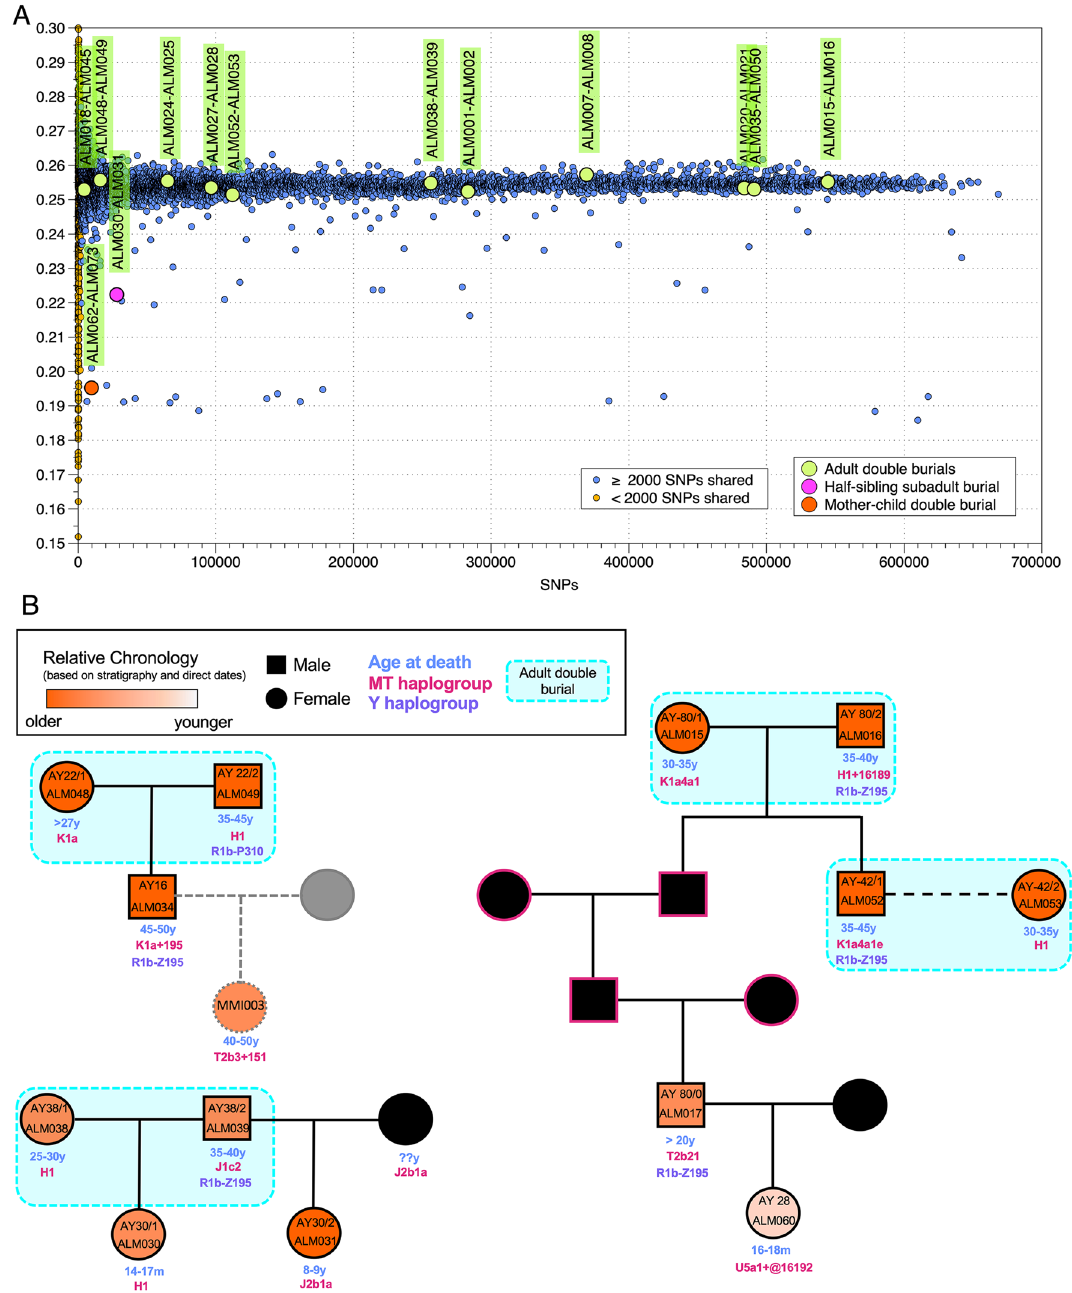
Figure 3. Summary of the genetic results from the double burials at Almoloya. ( A ) Results of the Pairwise- mismatch rate (PMR) analysis including all pairs of individuals from the Iberian Bronze Age available to date. The x-axis shows the number of overlapping SNPs between each pair and the y-axis the coefficient of relatedness. All adult double burials fall within the range of randomly drawn pairs of individuals from the Iberian Bronze Age. ( B ) Reconstructed pedigrees of three cases involving adult double burials and their common offspring. Below the colored squares and circles is the contextual information of all adult double tombs, including sex, age at death, mitochondrial and Y-chromosomal haplogroups, direct 14 C dates, as well as stratigraphy. Pink outlines reflect interchangeable genetic sexes and gray dashed lines indicate pedigrees reconstructed from low coverage